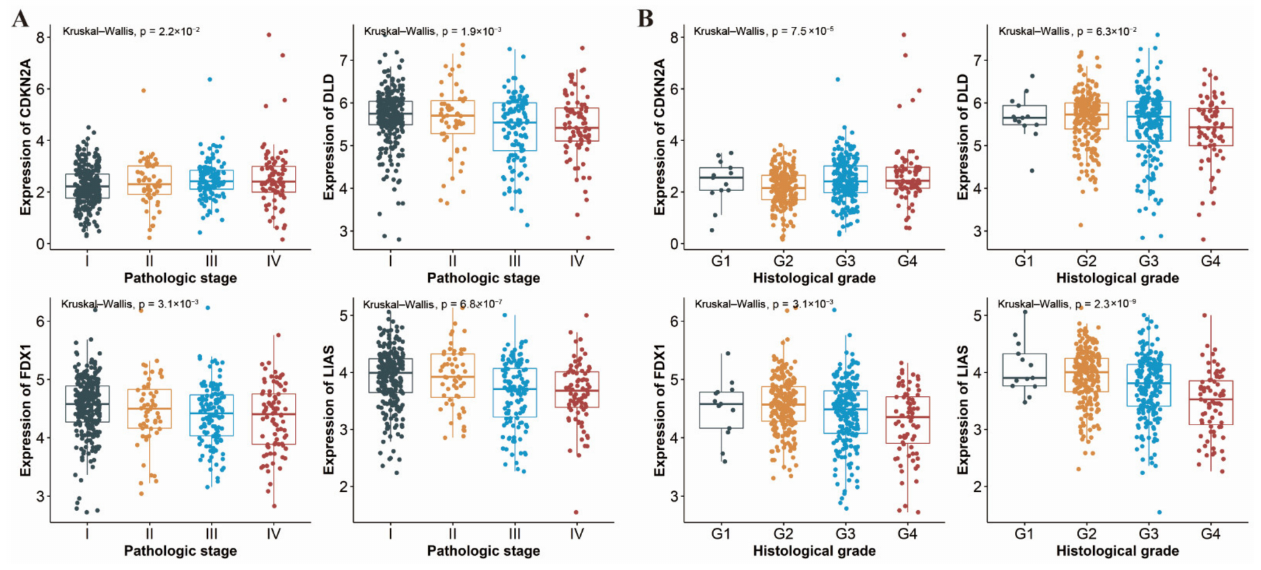
Figure 8. Expression of CDKN2A, DLAT, FDX1 and LIAS in a different ( A ) pathologic stage and ( B ) histological grade of ccRCC patients, respectively. ccRCC: clear cell renal cell